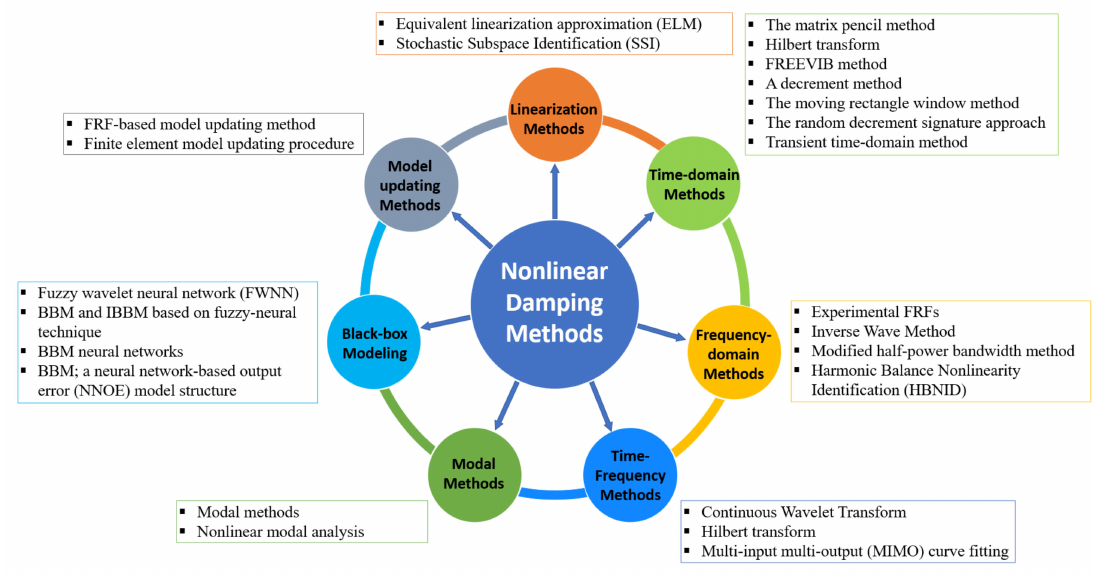
Figure 2. Nonlinear damping identification